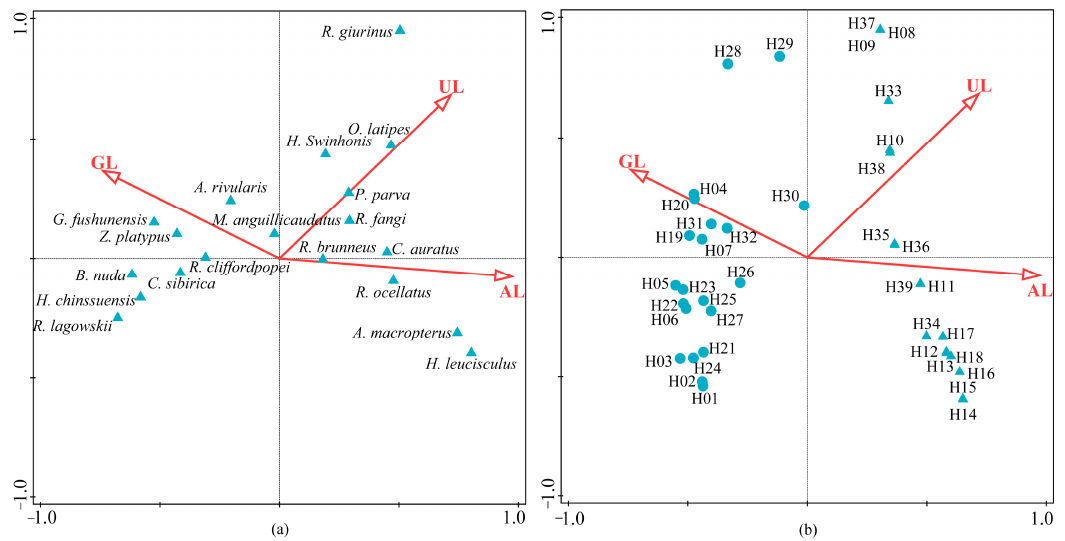
Figure 6. Ordination plot of the CCA for the sampled fish–environment factors ( a ) and site–environment factors ( b ) in the Hun River Basin (b: the circles represent the sites located mid-upstream, while the triangles represent the sites located downstream).